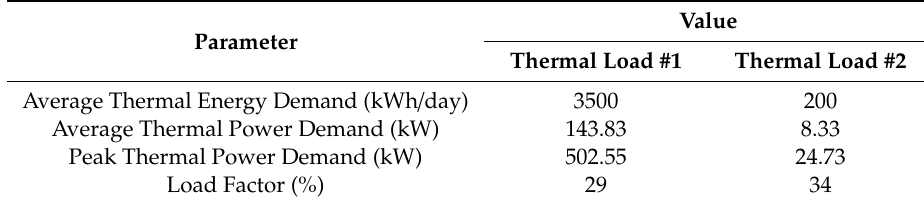
Figure 2. Total thermal load profile (first year of project lifetime). Table 2. Specifications of the thermal load.